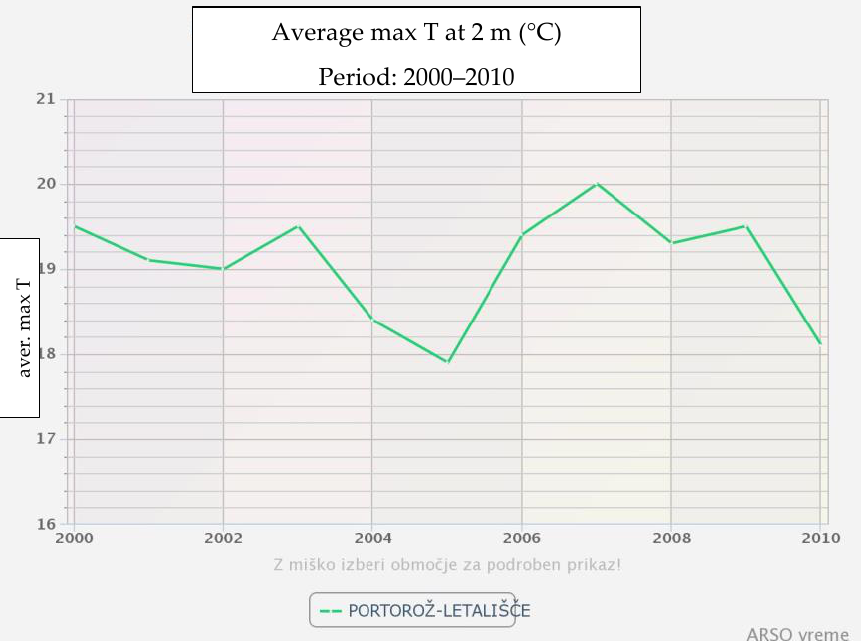
Figure 4. Average maximum temperature for locality 7 — Dragonja, measured from nearby climate station Portorož (source: https://meteo.arso.gov.si/met/sl/archive, accessed on 27 January 2023).